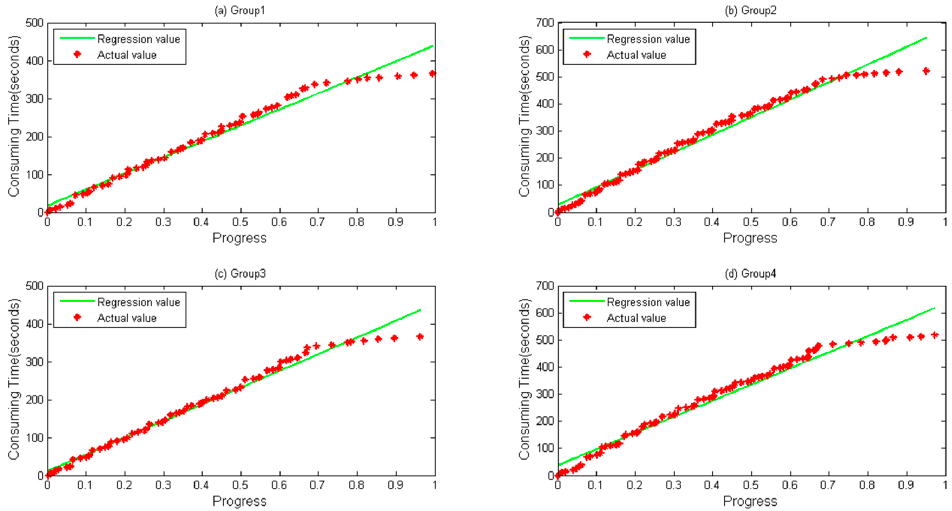
Figure 4. Linear Regression calculated by direct regression algorithm during a lifetime. ( a ) Group 1; ( b ) Group 2; ( c ) Group 3; and ( d ) Group 4 data and their values calculated by Linear Regression for WordCount sample.